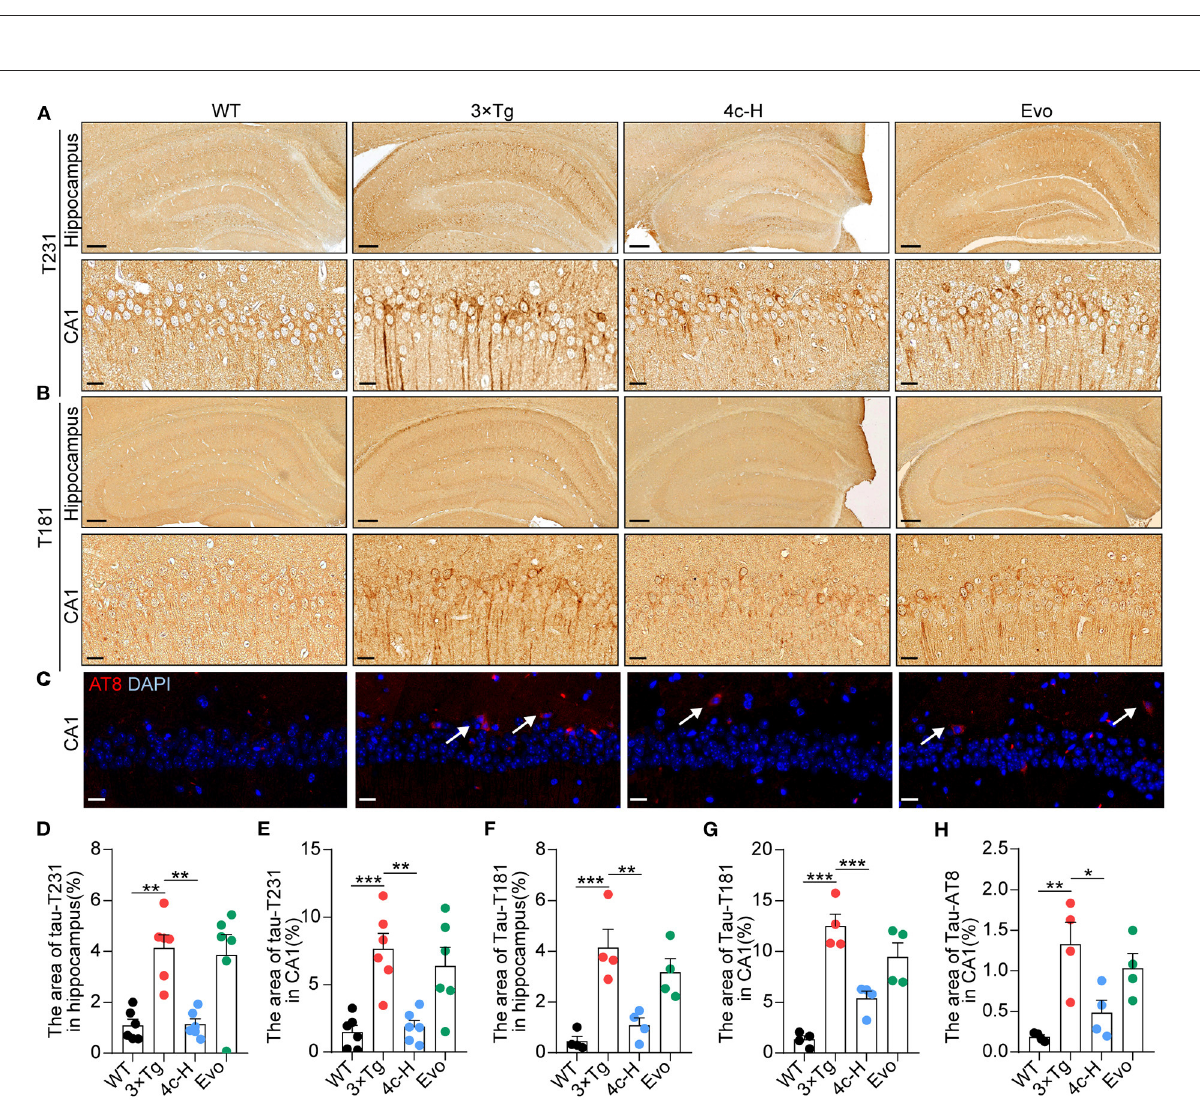
FIGURE5 Determination of Tau phosphorylation in brain tissues. After the MWM test, mice from the WT, 3 x Tg, 4c-H, and Evo groups were sacrificed, and brain tissues were sampled for histological staining. (A, B) Tau phosphorylation was detected via immunohistochemical staining with T231 and T181 antibodies in the mouse hippocampus (scale bar = 200 µ m) and hippocampal CA1 region (scale bar = 20 µ m). (C) Tau phosphorylation was detected using immunofluorescent staining with the AT8 antibody in the mouse hippocampal CA1 region (white arrowheads indicate AT8-positive cells, scale bar = 20 µ m). (D–G) Tau phosphorylation as detected using T231 and T181 antibodies in the hippocampus and the hippocampal CA1 region was quantified by the density of staining using ImageJ. (H) Tau phosphorylation as detected by the AT8 antibody was quantified by red fluorescence. Data are represented as mean ± SEM, n = 6; * P < 0.05, ** P < 0.01, and *** P <